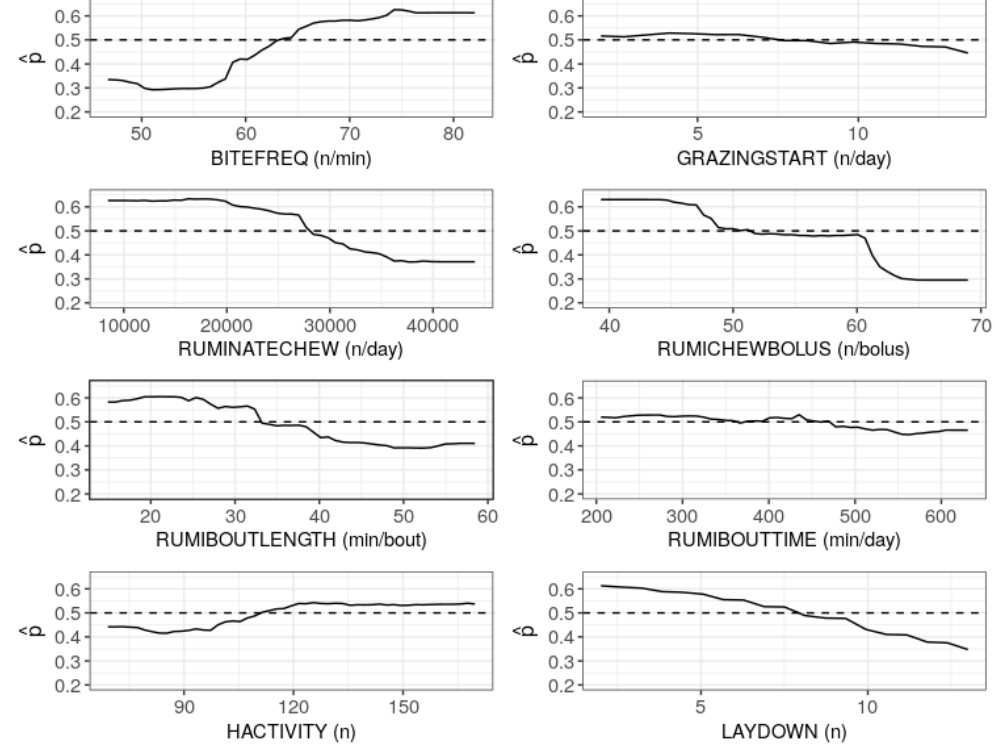
Figure 3. Partial dependence plots for the marginal effects of the predictors on the random forest model: Estimated probability of insufficient allowance versus the observed values of each predictor in the combined